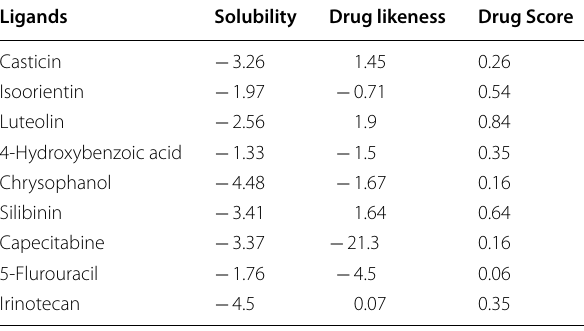
Table 2 Drug likeness score of different phytochemicals predicted based on Lipinski